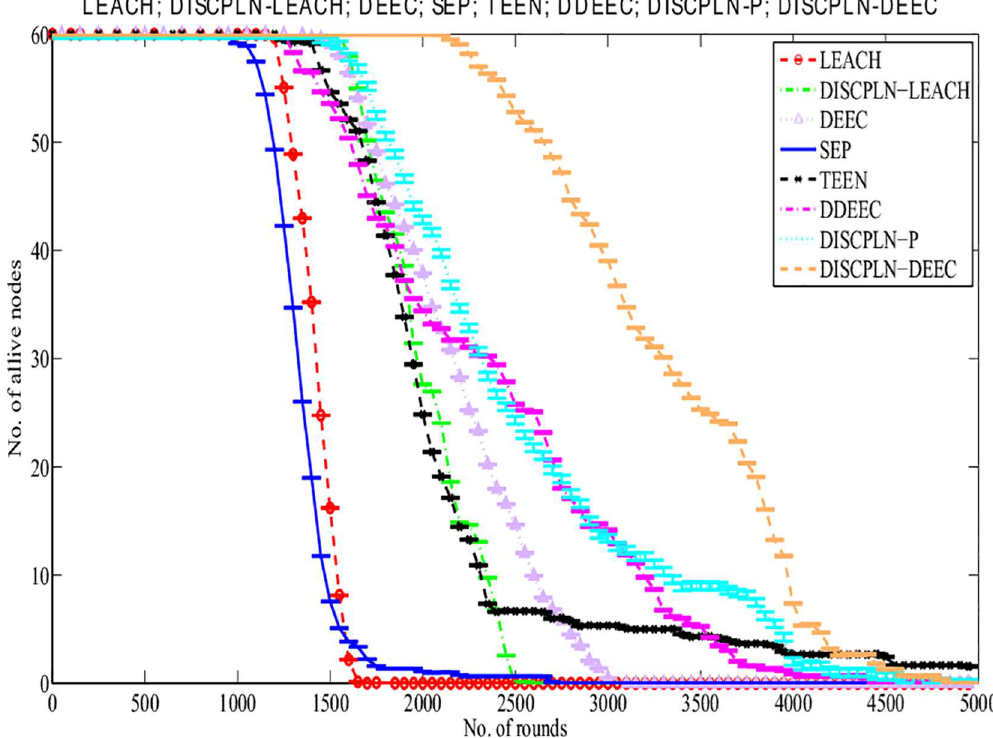
Fig 6. Performance comparisonbasedon stabilityperiod for